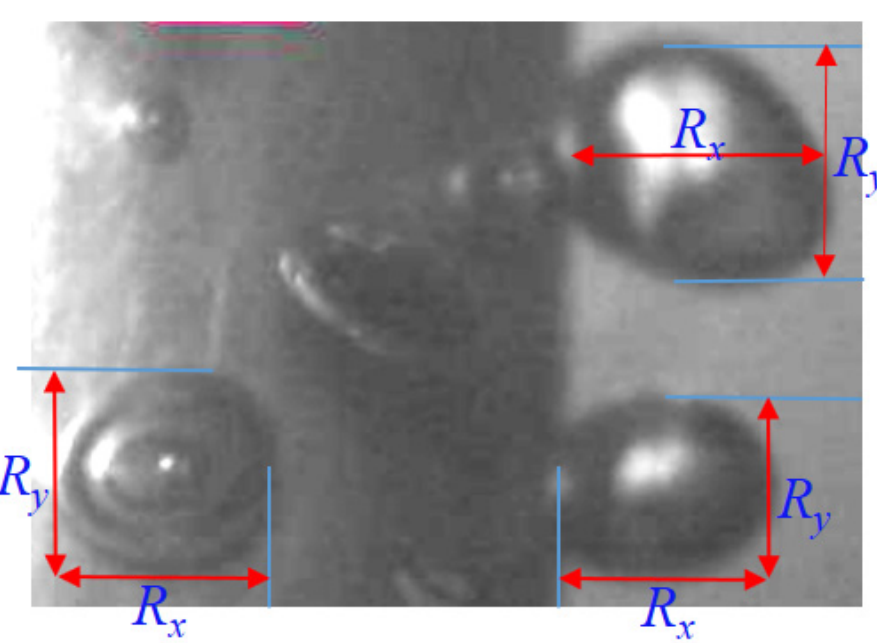
Figure 3. Bubble size definition.